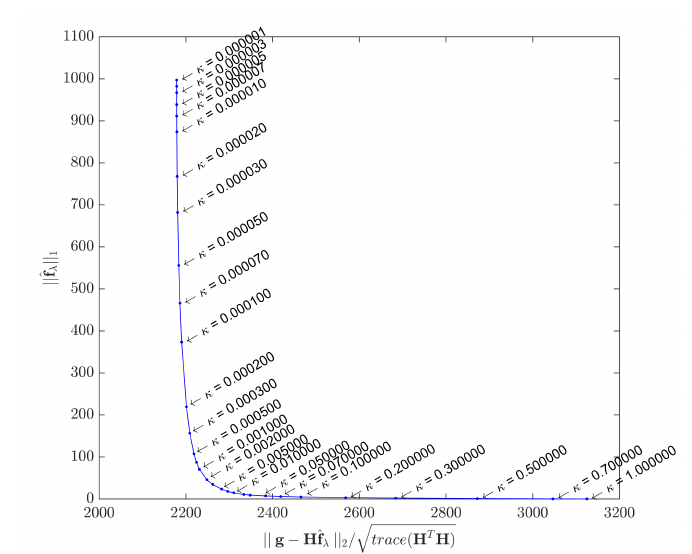
Figure 5. L-curve by IRLS method - Synthetic dataset. Parameter κ ranges from 10 − 6 to 1. The curvature region is approximately delimited by κ = 5 × 10 − 4 and κ = 5 × 10 − 2 .